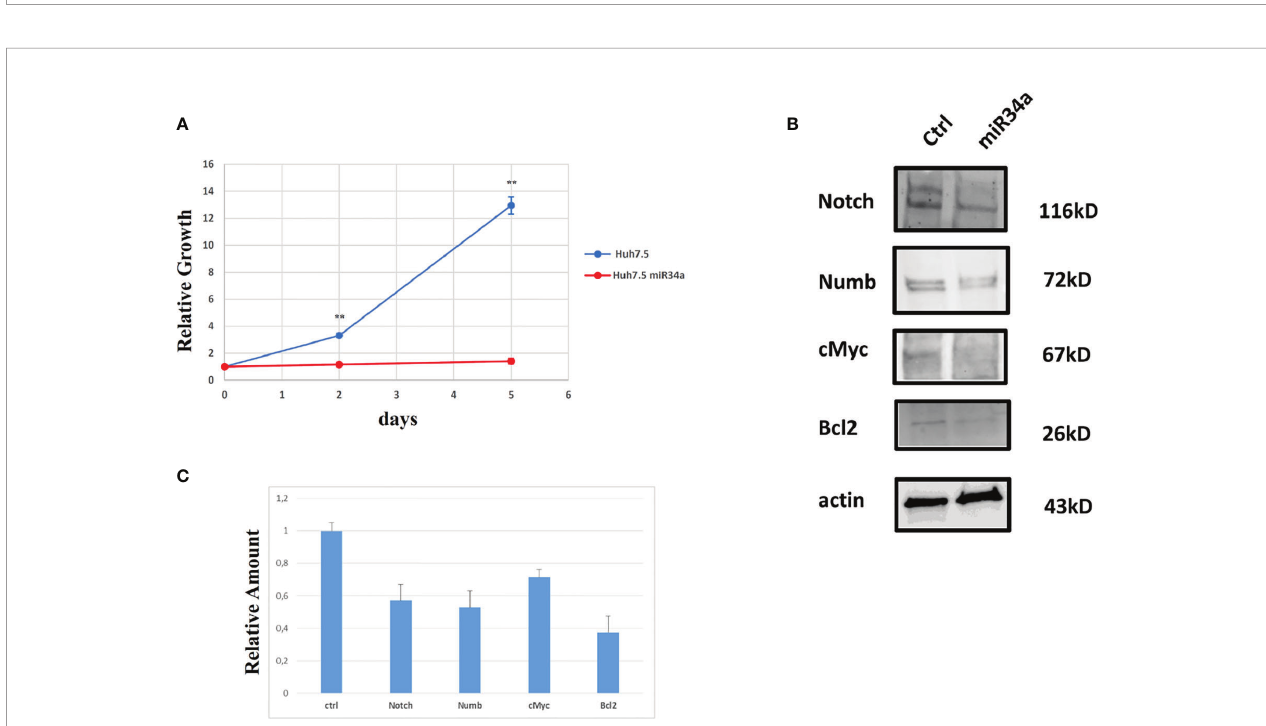
FIGURE 2 | Morphological evaluation of Huh7.5 control and overexpressing miR34a in bright- fi eld microscopy. The cells ’ cell morphology after infection appears clearly modi fi ed, and the cellular density is lower than control cells.